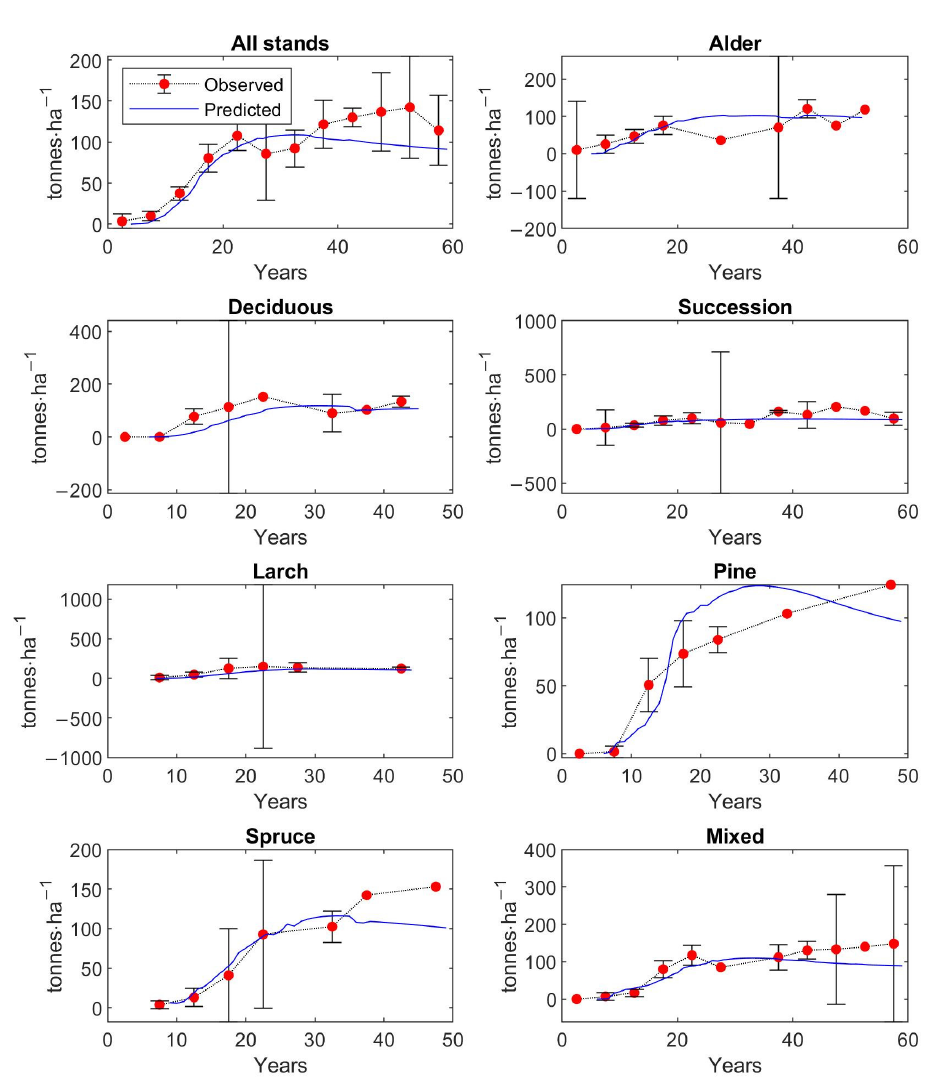
Figure A2. Verification of the model by the comparison of the observed 5-year average values with average predicted values of AGB, with a 95% confidence interval, according to individual forest types.